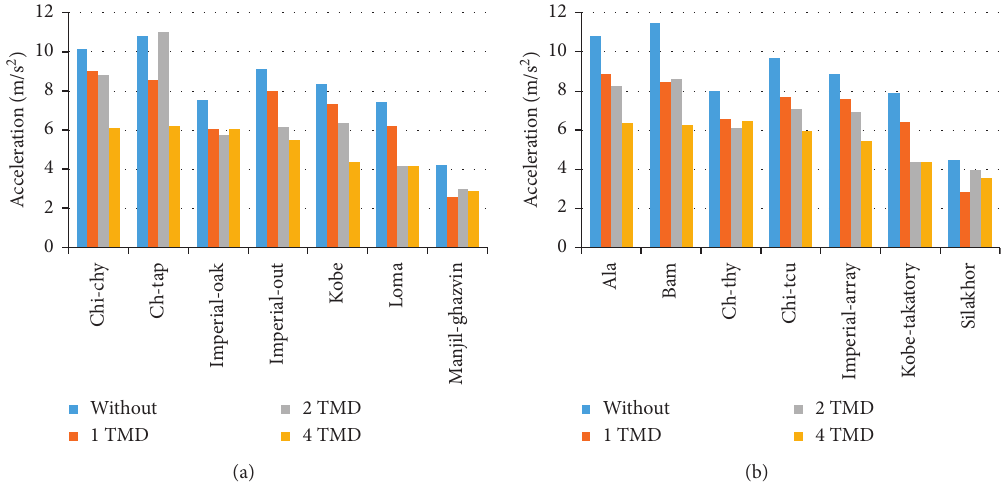
Figure 14: Acceleration with damper in the ninth story under the near-field (right) and far-field (left) earthquakes in the regular 10-story model.